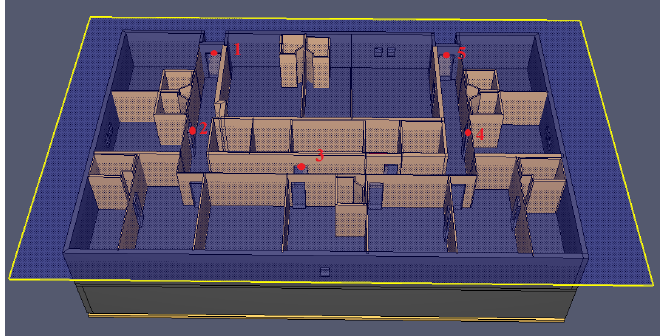
Figure 4. Detector layout.